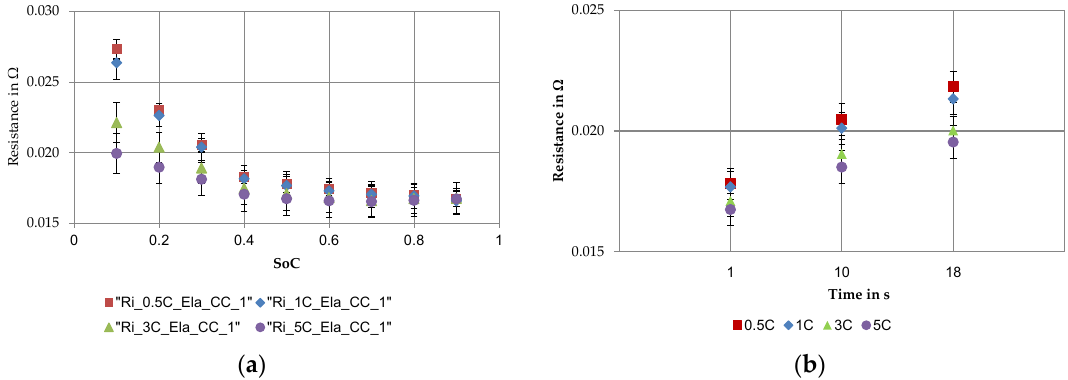
Figure 9. The main results of the internal resistance determination of the discharge pulse at different current rates averaged over all cells: ( a ) state of charge (SoC) dependent absolute values of internal resistance and ( b ) time dependent absolute values of internal resistance at a SoC level of 50%.